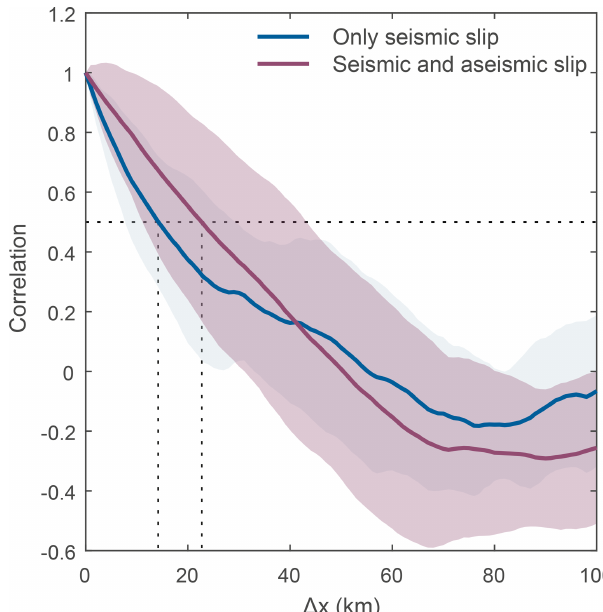
Figure 11. Similarity of river profiles along the strike of the fault. Change of the average coefficient of correlation in between rivers located along the strike of the fault, with river interdistance (cid:49)x . The double standard deviation is shown by the extent of the shaded area. In blue is the “only seismic slip” model, and in purple is the “seismic and aseismic slip” model. The average coefficient of cor- relation and its standard deviation are measured along the diagonals of the correlation matrix (Fig.